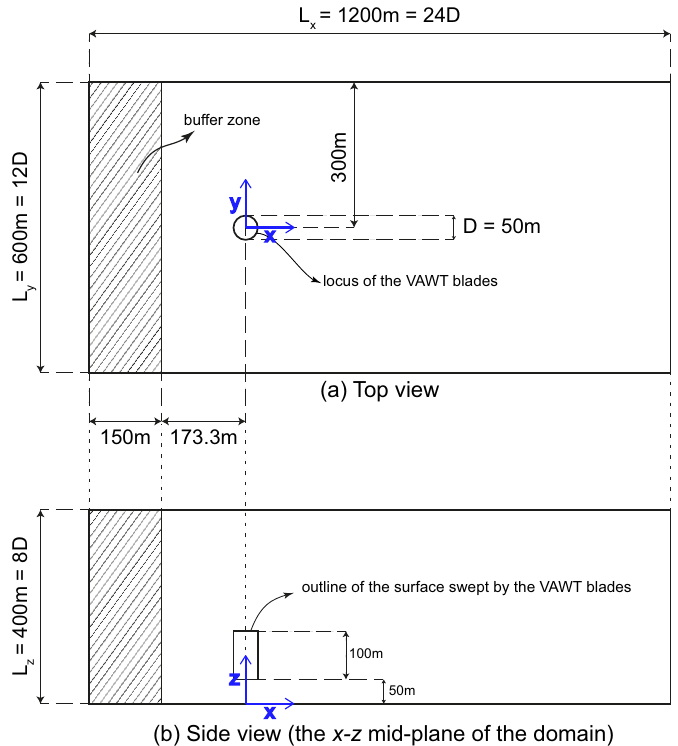
Figure 2. Plane views of the geometrical configuration of the simulations: ( a ) top view of the domain; ( b ) side view of the domain, seen in the x - z mid-plane of the domain.